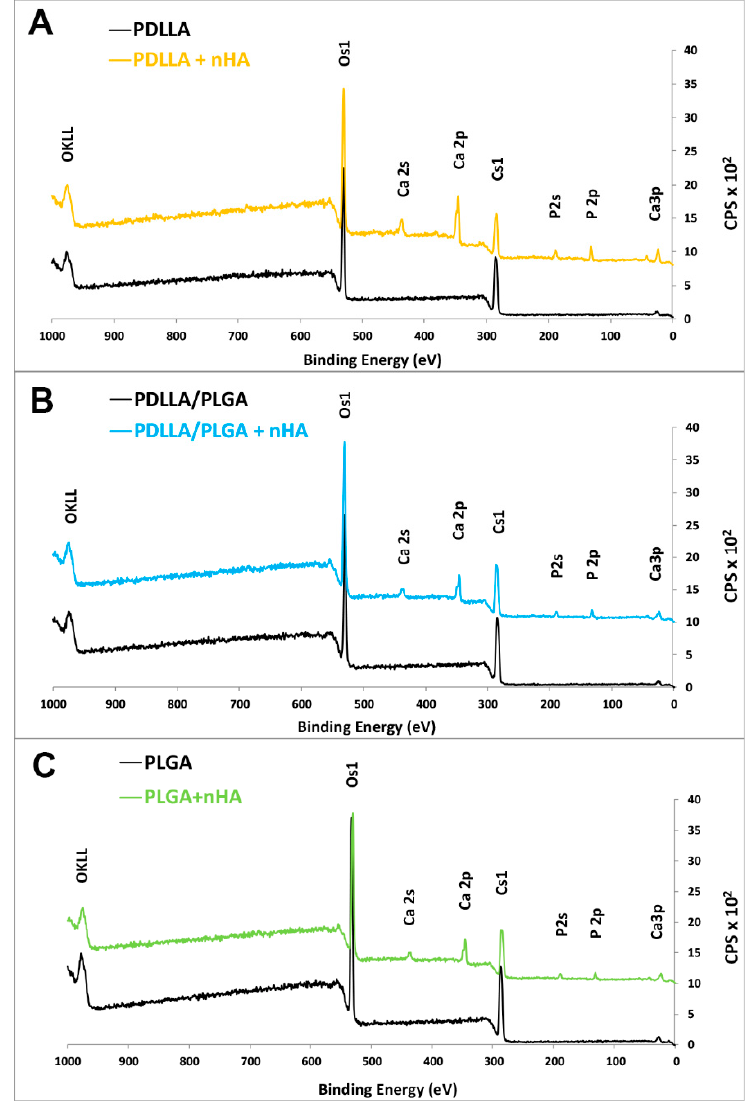
Figure 7. XPS spectra of unmodified and nHA double-layer sonocoated materials: ( A ) PDLLA; ( B ) PDLLA / PLGA; and ( C )